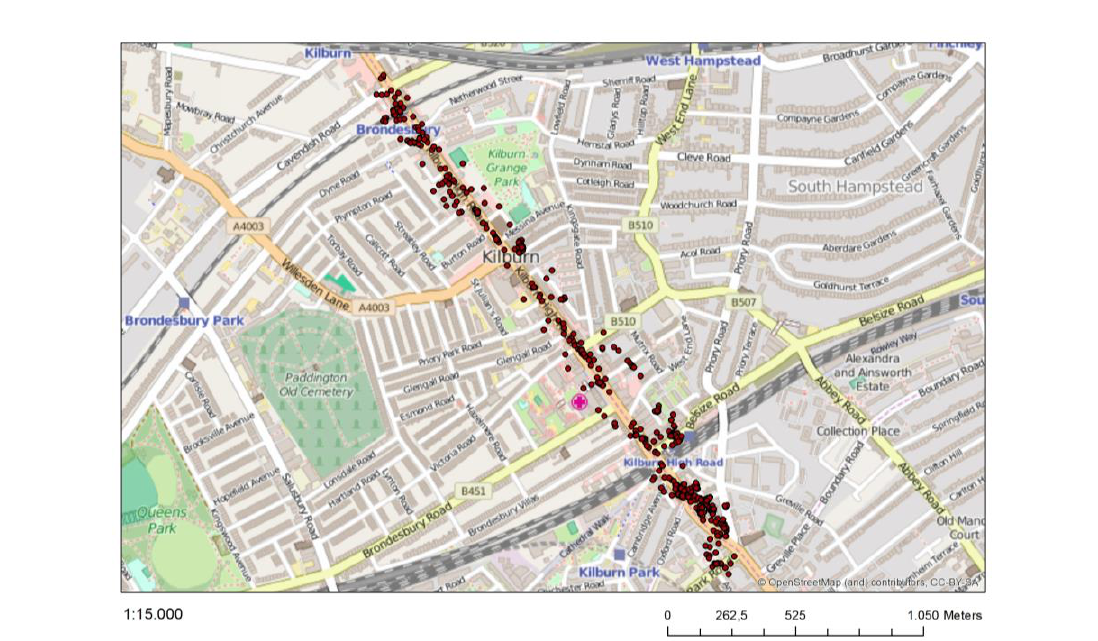
Figure 2. The distribution of georeferenced Tweets and Flickr photo along Kilburn High Road.